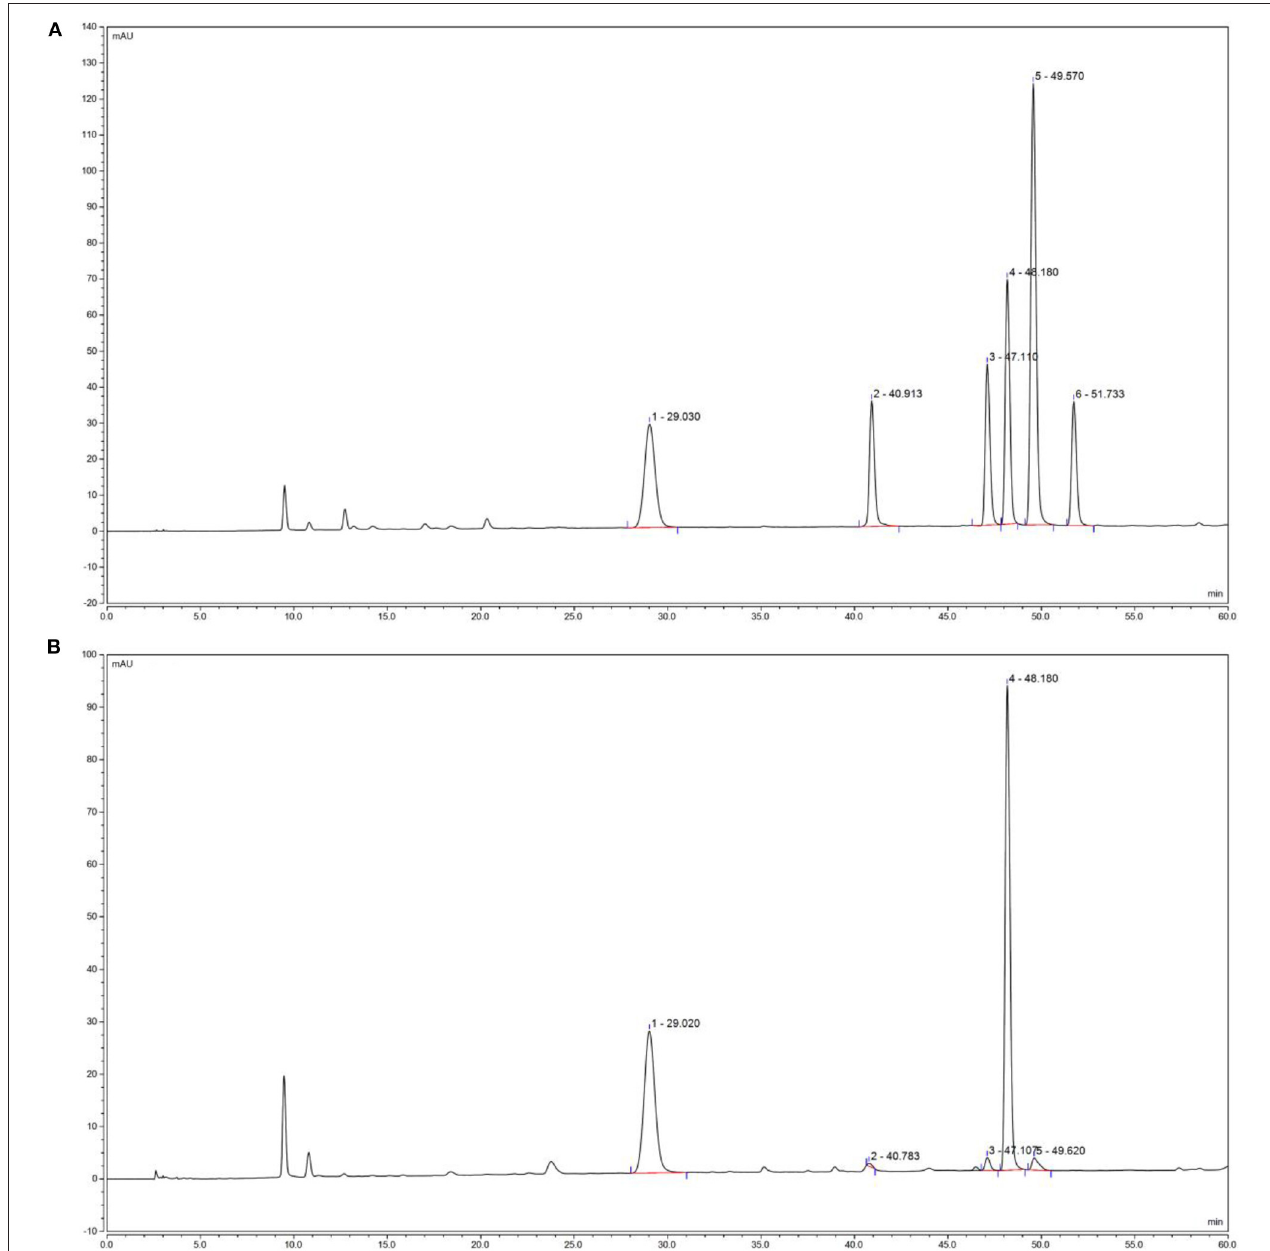
FIGURE 1 | Polysaccharides constituents of blood cora. (A) Standard chromatograms; (B) blood cora polysaccharides chromatograms. 1: mannitol; 2: ribose; 3: anhydrous glucose; 4: galactose; 5: